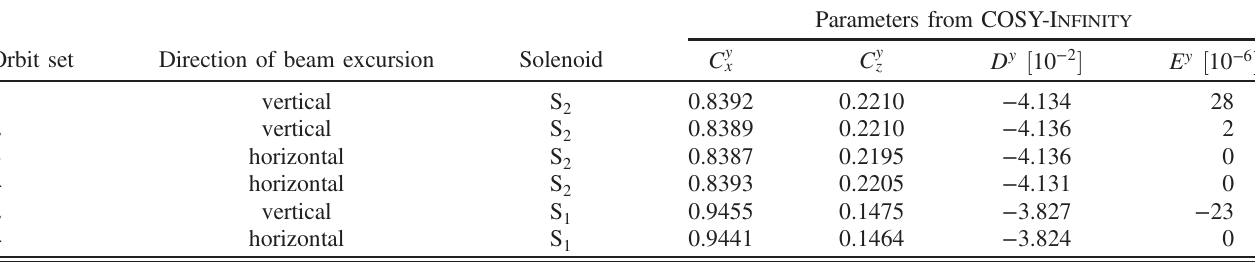
TABLE IV. Summary of parameters of modifications of the spin transfer properties of the COSY ring by the orbit excursions induced by different steerer settings (listed in Table III) as determined from the COSY-I NFINITY simulations for rotations of solenoids S 1 and S 2 around the vertical y -axis. Here C y x;z are defined by Eq. (64), D y is defined by Eq. (66), and E y is defined by Eq. (67). To emphasize the independence on the orbit setting, for solenoid S 2 we show results for all sets 1 to 4, while for solenoid S 1 , we restricted ourselves to sets 2 and